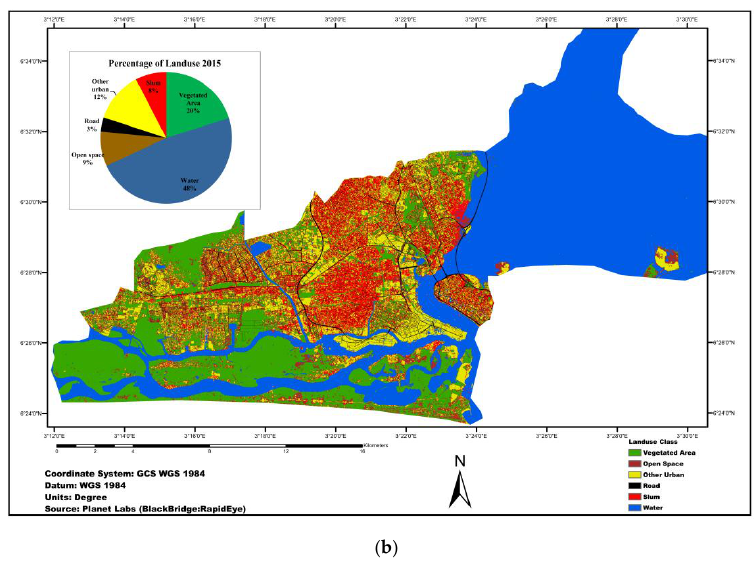
Figure 5. ( a ) Land use/cover map of study area in 2009; and ( b ) land use/cover map of the study area in 2015.